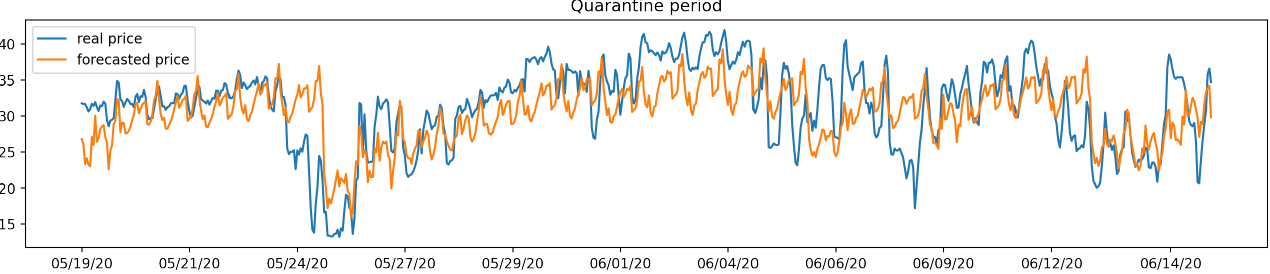
Figure 6. Comparison between actual and predicted price by model LSTM using validation data for the quarantine data period.